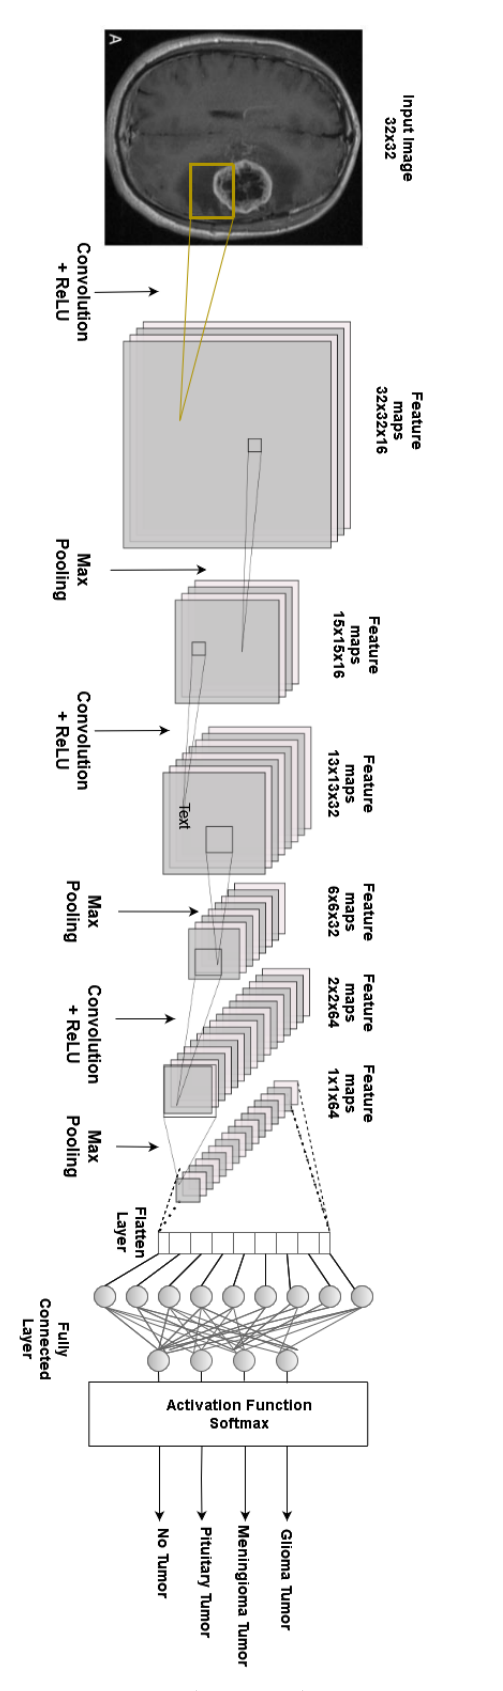
Figure 2. Proposed CNN